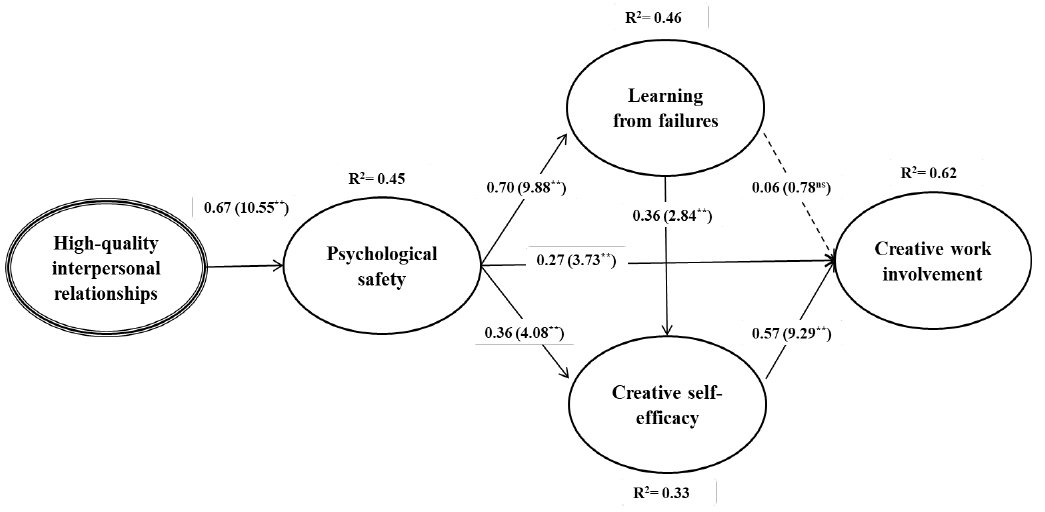
Figure 2. The results of structural equation modelling for the extended model of creativity. Note: ns = not significant, ** p < 0.01. The numbers that are presented in parentheses are t-values, and those that are outside the parentheses are standardized path coefficients. The dotted line indicates a non-significant effect.